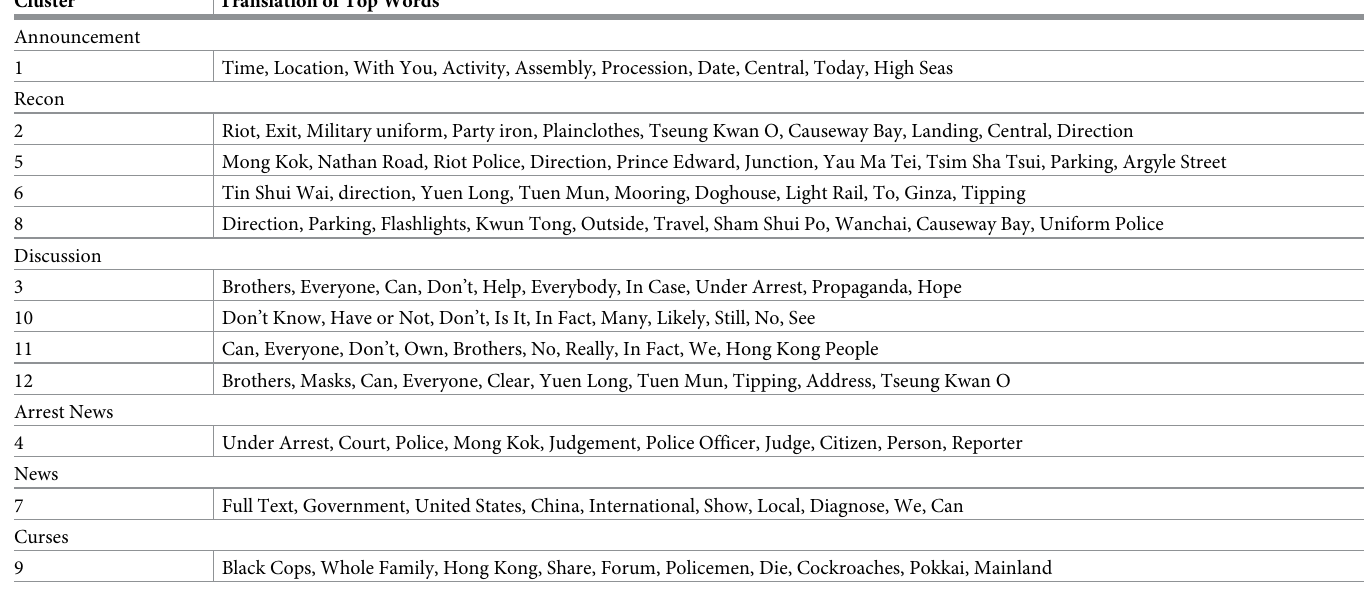
Table 1. Top words per topic